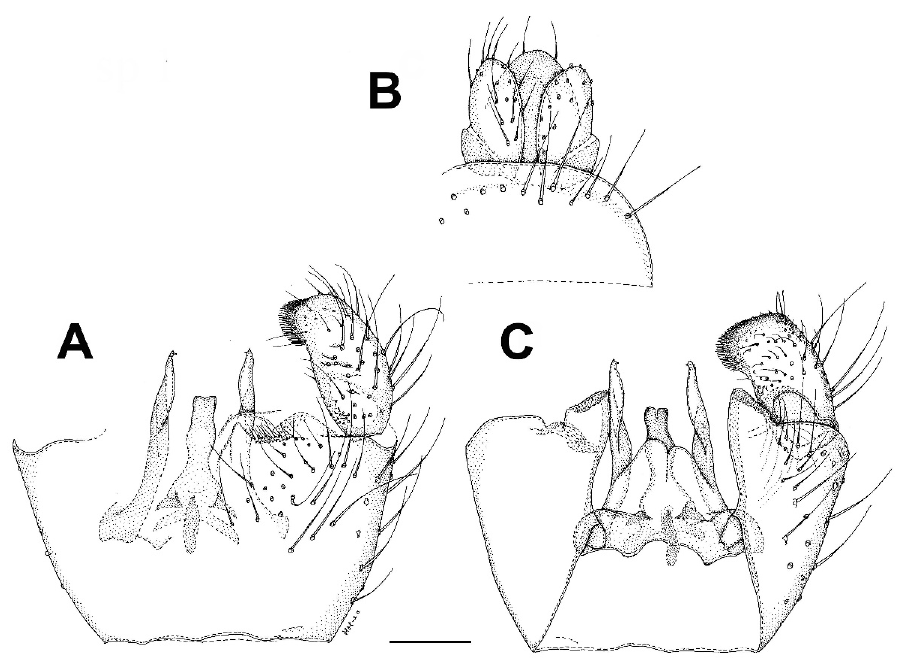
Figure 2. Male terminalia of Bolitophila nikolae Šev č ík sp. nov. (holotype): ( A ) ventral view, ( B ) posterior part of abdomen in dorsal view, ( C ) dorsal view. Scale bar: 0.1 mm.